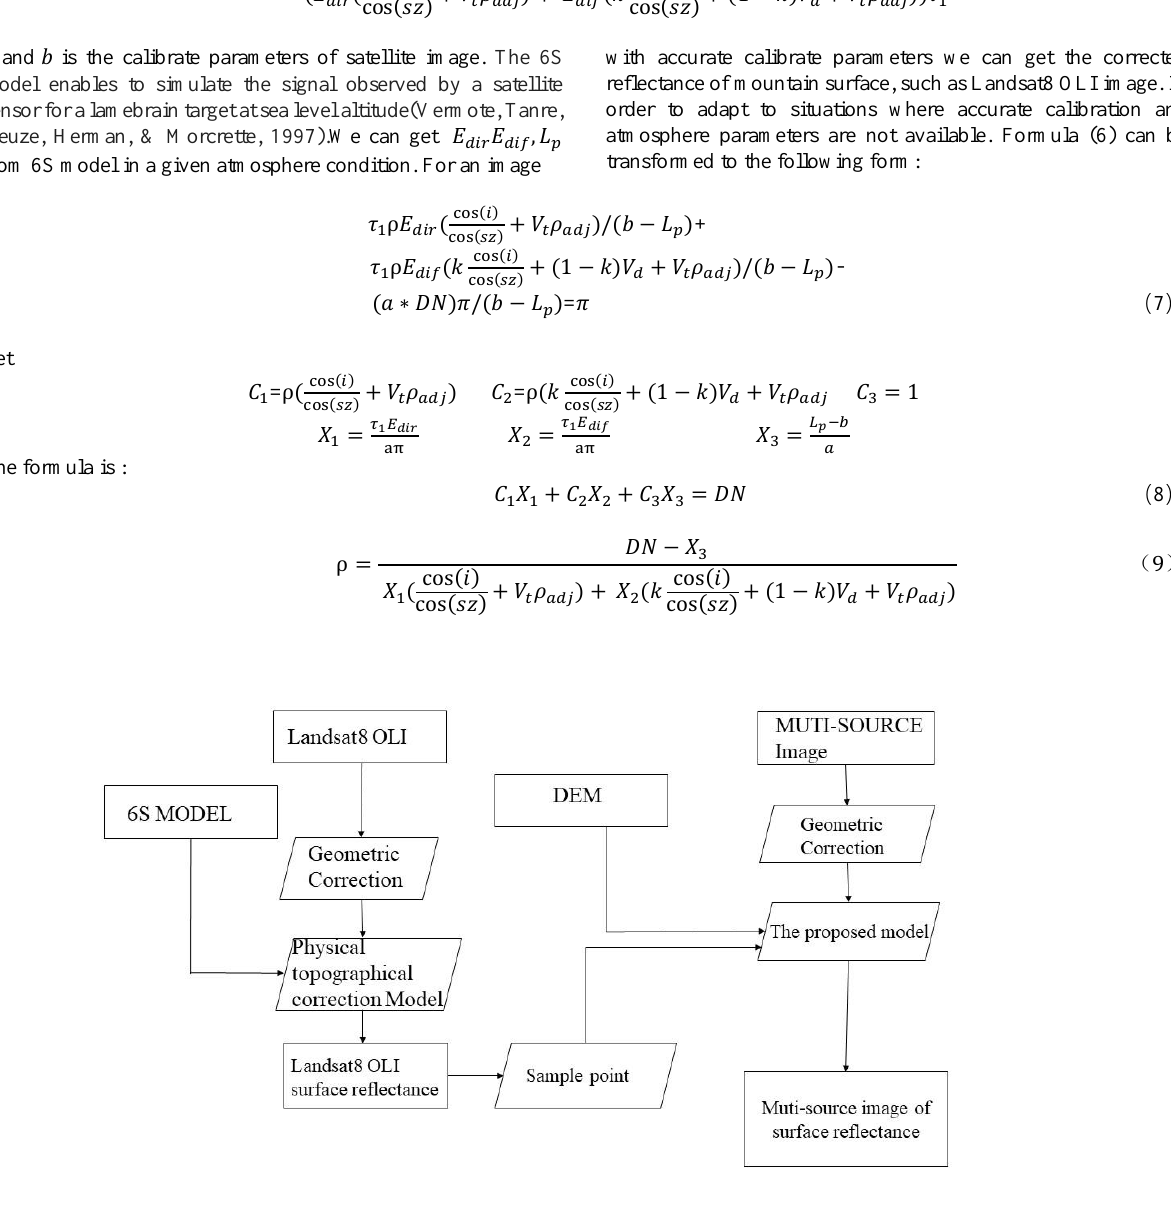
Fig.2.1 flow chart of this model determined by sensors and atmosphere conditions. Figure 2.1 shows the flow chart of this